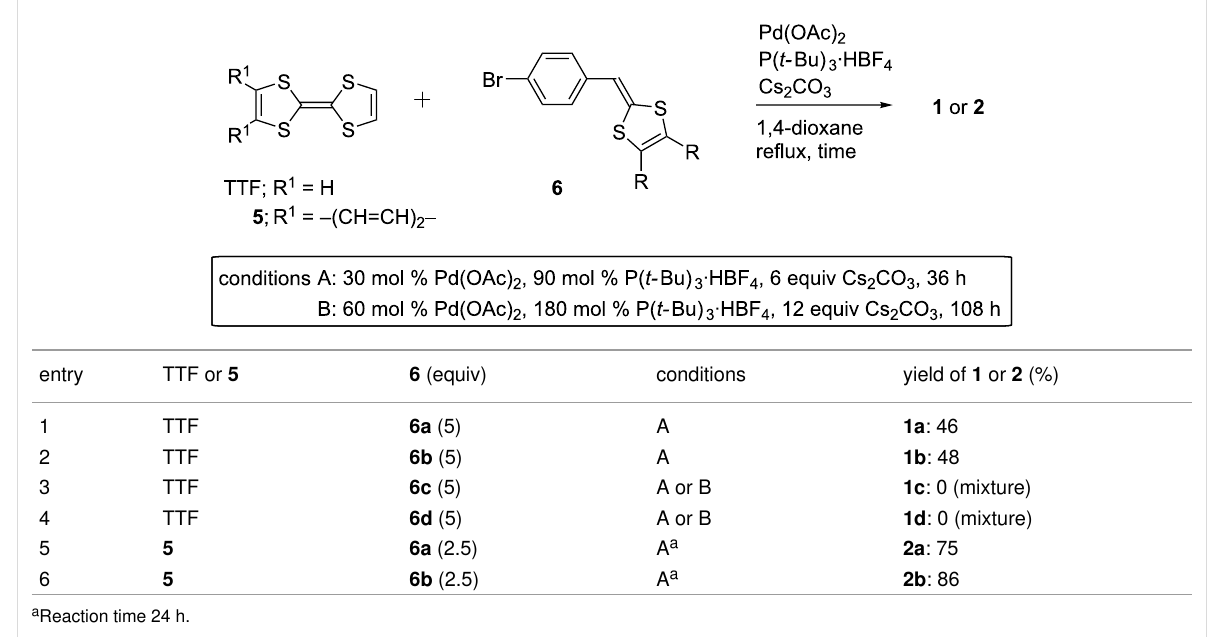
Table 1: Synthesis of compounds 1 and 2 .